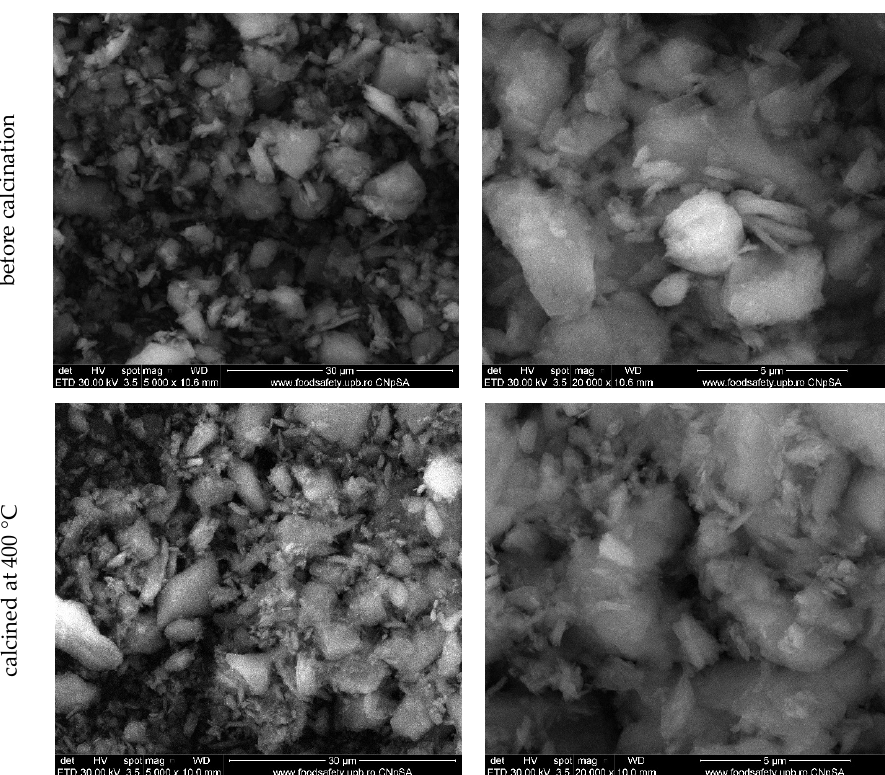
Figure 5. SEM images of the GDAH-04 powder before the thermal treatment and after calcination at 400 °C. The GDAH-05 sample exhibited a different behavior in terms of its morphology, which was probably due to the larger size of the constituent particles (<45 µm = 0.001%; >150 µm = 6.54%) in comparison with the other ceramic powders (Figure 6). Hence, large